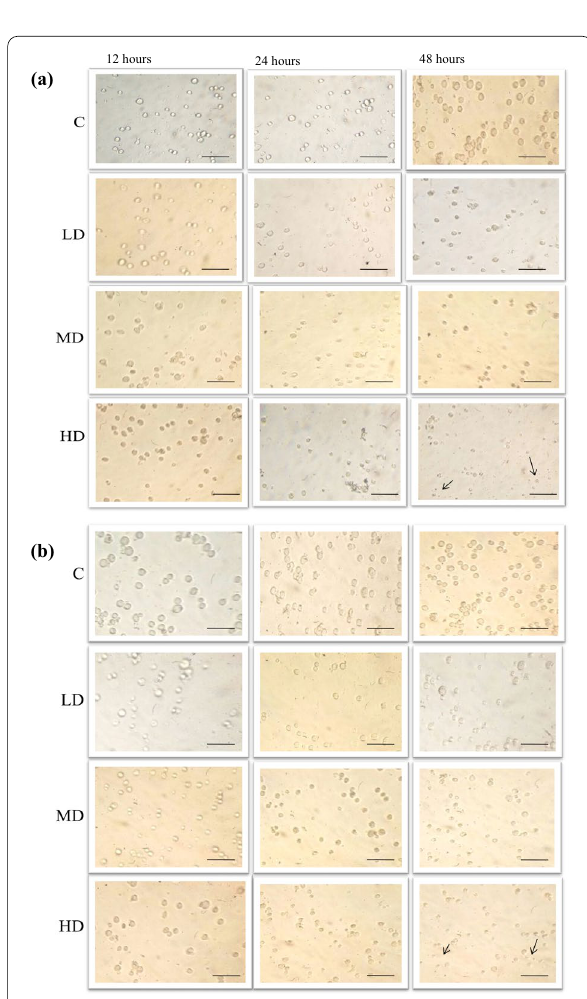
Fig. 2 Sf9 cell morphology after treatment with Ammo ( a ) and Profex ( b ) for 12, 24 and 48 h. Arrow indicates the change in Sf9 cell morphology such as cell shrinkage, fragmentation after 48 h of treatment with HD. Here, C control, LD low dose, MD medium = = = dose and HD high dose. Bar 50 = =